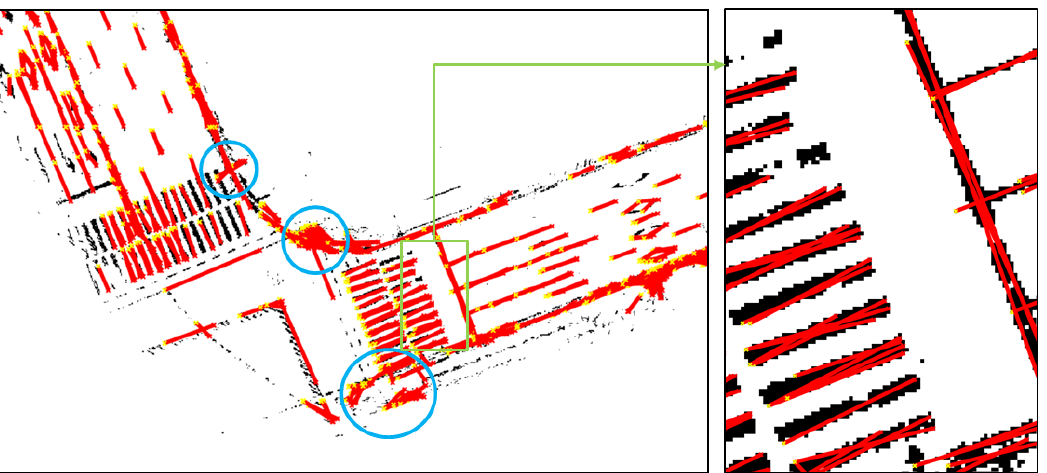
Figure 9. Line extraction results for road markings.